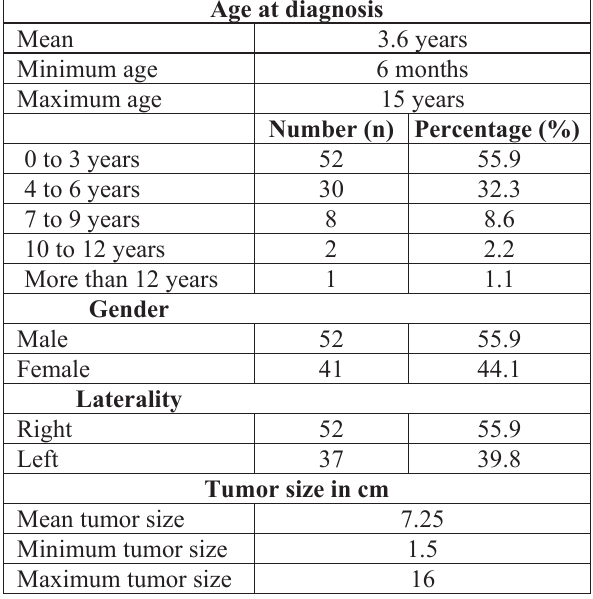
Table-1: Principal clinicopathological features of